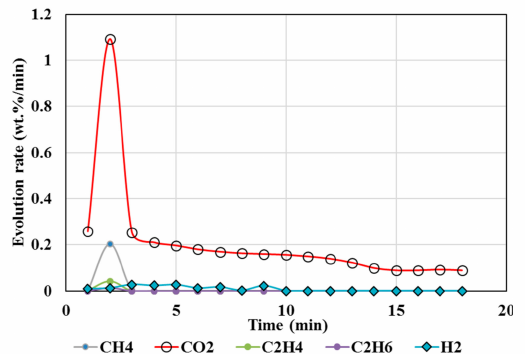
Figure 5. Gas Chromatography results of isothermal calcination of magnesite + plastics (Test 6, MgCO 3 · xH 2 O; resin) at 1000 ◦ C.